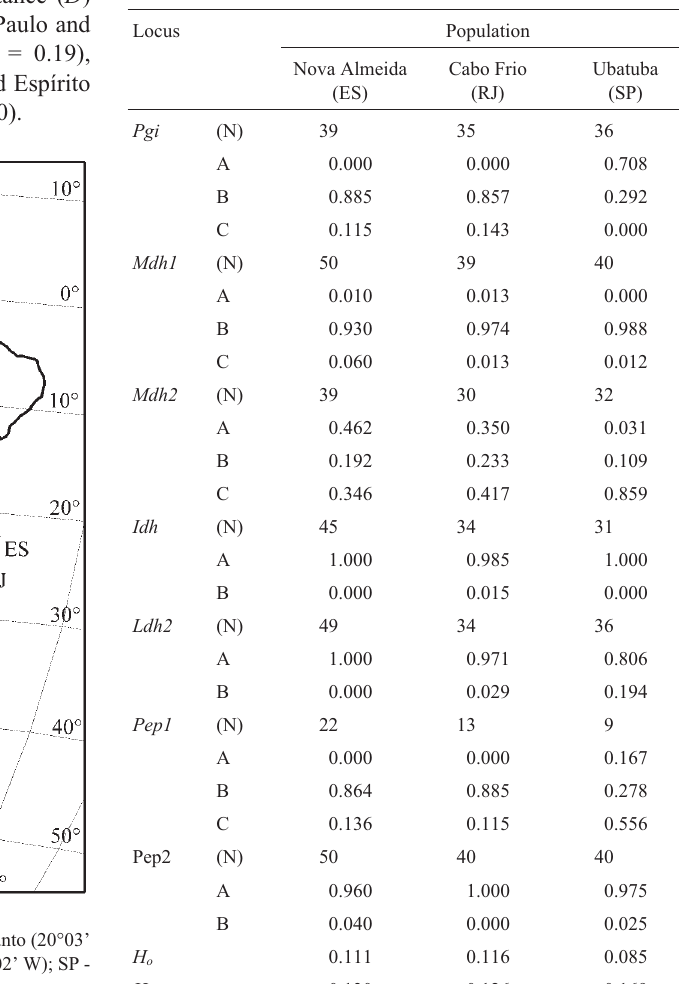
Table 1 - Allele frequencies and sample sizes (N) at seven polymorphic loci . The other three loci : Adh , Ak and Ldh1, were monomorphic in all populations. H o and H e observed and expected heterozygosities